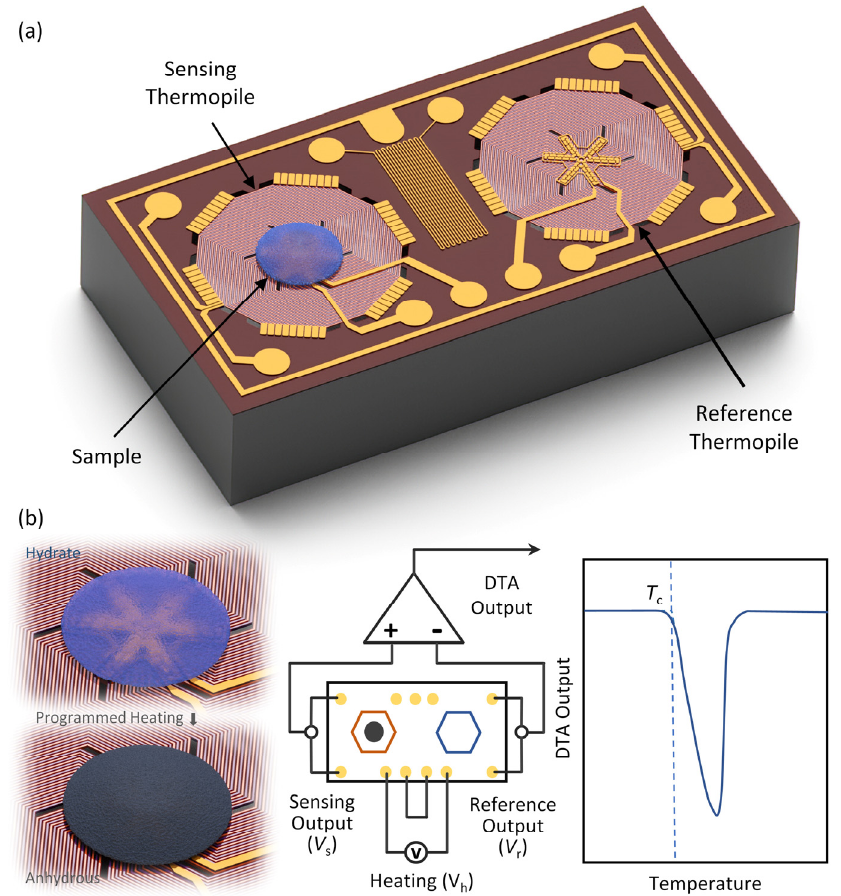
Figure 1. Design and working principle of the proposed MEMS thermopile-based DTA chip. ( a ) Schematic illustration of the MEMS DTA chip consisting of a pair of differential thermopiles for sensing and reference, respectively. ( b ) Schematic illustration of the working principle of the MEMS DTA chip. The sample is loaded within the sample area and heated. The temperature change caused by the endothermic (or exothermic) process is recorded as the DTA output.